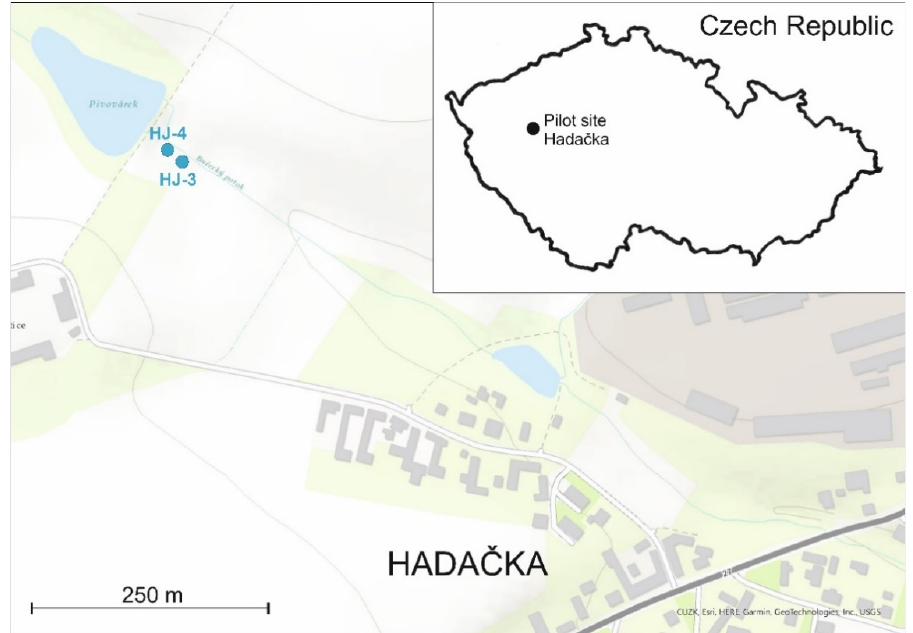
Figure 5. The location of the Hada č ka site.